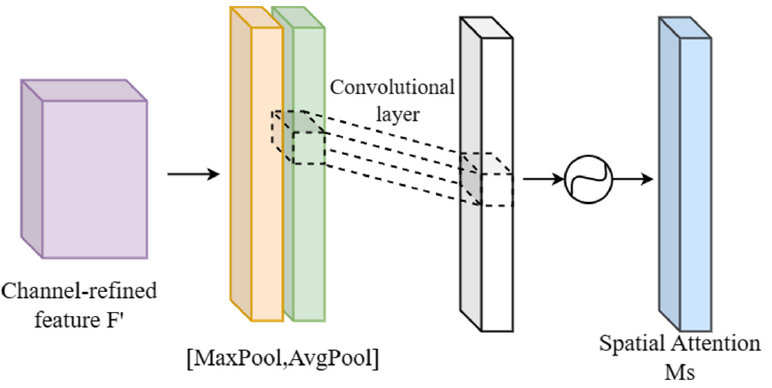
Figure 6. Spatial a tt ention module.